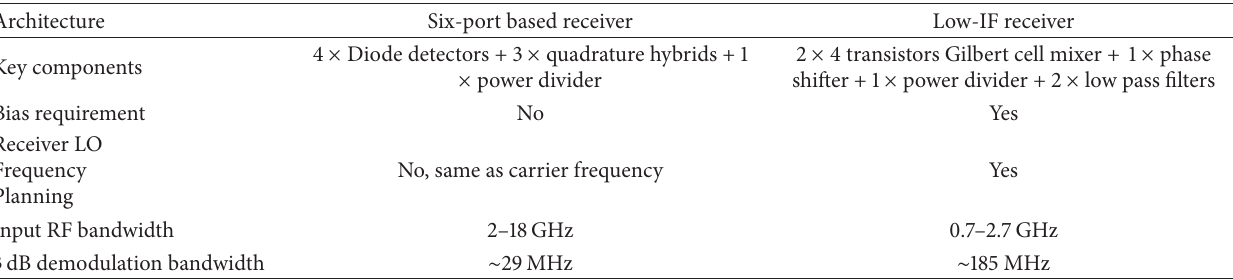
Table 2: Architectural comparison between SPR and low-IF receiver.